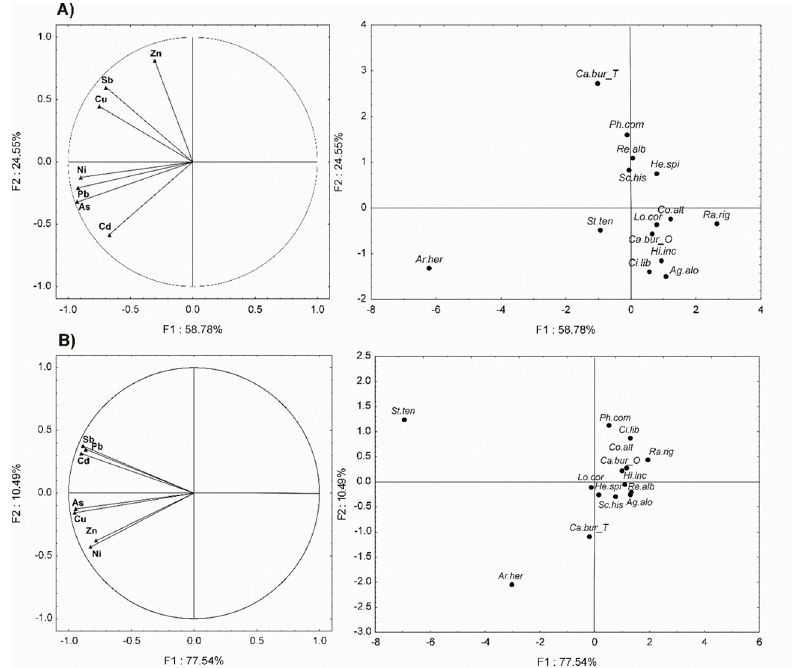
Figure 4. Plot of axes 1 and 2 of the principal components analysis (PCA) on the means of the metals concentrations separately in the shoots ( A ) and the roots ( B ) for the studied species. Abbreviation